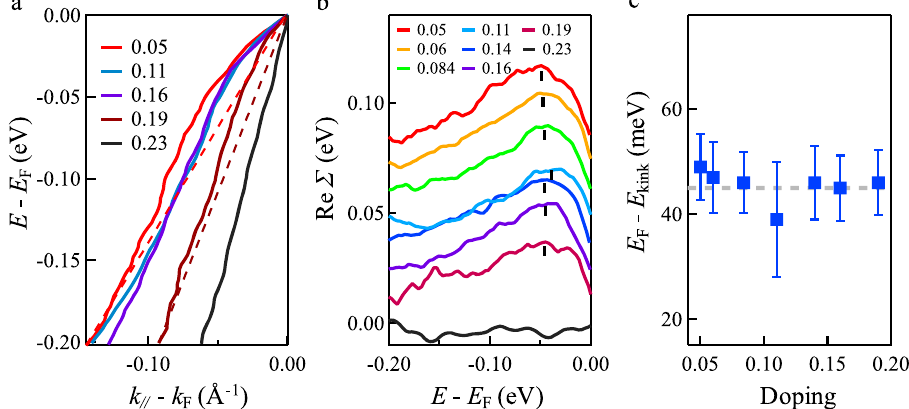
Fig. 2 Universal antinodal kink in LCCO. a MDC-derived antinodal band dispersions at different doping levels are displayed as the solid lines, and the dashed lines represent the linear bare bands connecting the E F to E F − 200 meV. b Extracted real part of the self-energies, the curves are offset vertically for clarity. c Doping dependence of the peak position of Re Σ , the mean energy of the kink is at ~ 45 meV. Error bars are the overestimated uncertainty of determining the peak Σ versus E − E renormalization effects in band dispersion are included in the self- F in Fig. 2b, where the curves are offset vertically for energy. The peak position of the real part of self-energy (Re Σ ) clarity. It is clear that except at n ~ 0.23, all the samples indicate a corresponds to the characteristic energy of the kink. We extract kink at 40 – 50 meV, with the mean energy at ~ 45 meV, as the antinodal band dispersions as shown in Fig. 2a and plot the Re summarized in Fig. 2c. In the underdoped region below 0.11, the